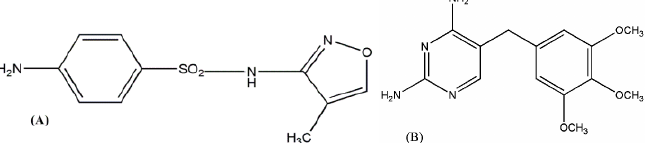
Figure 1. Structural formula of Sulfamethoxazole (A) and Trimethoprim